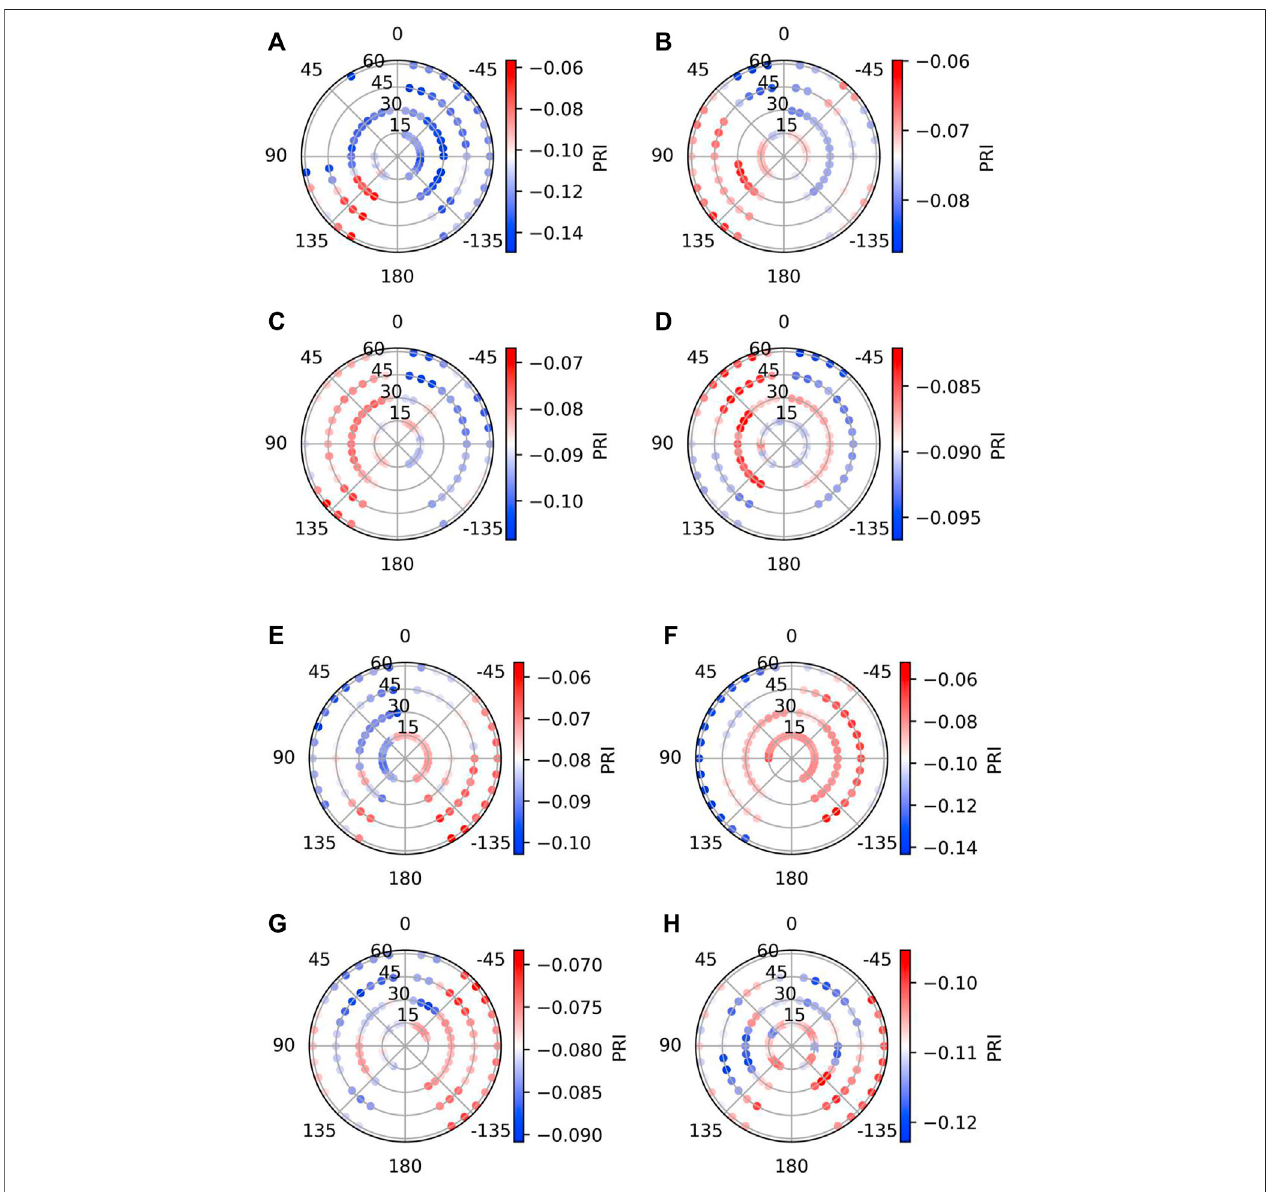
FIGURE 3 | Multi-angle PRI within 15 min at 10:30 (A – D) and 13:30 (E – H) in August 10, August 29, September 12, and September 23, 2018. The polar angles represent OAA, and the polar diameter represents OZA.